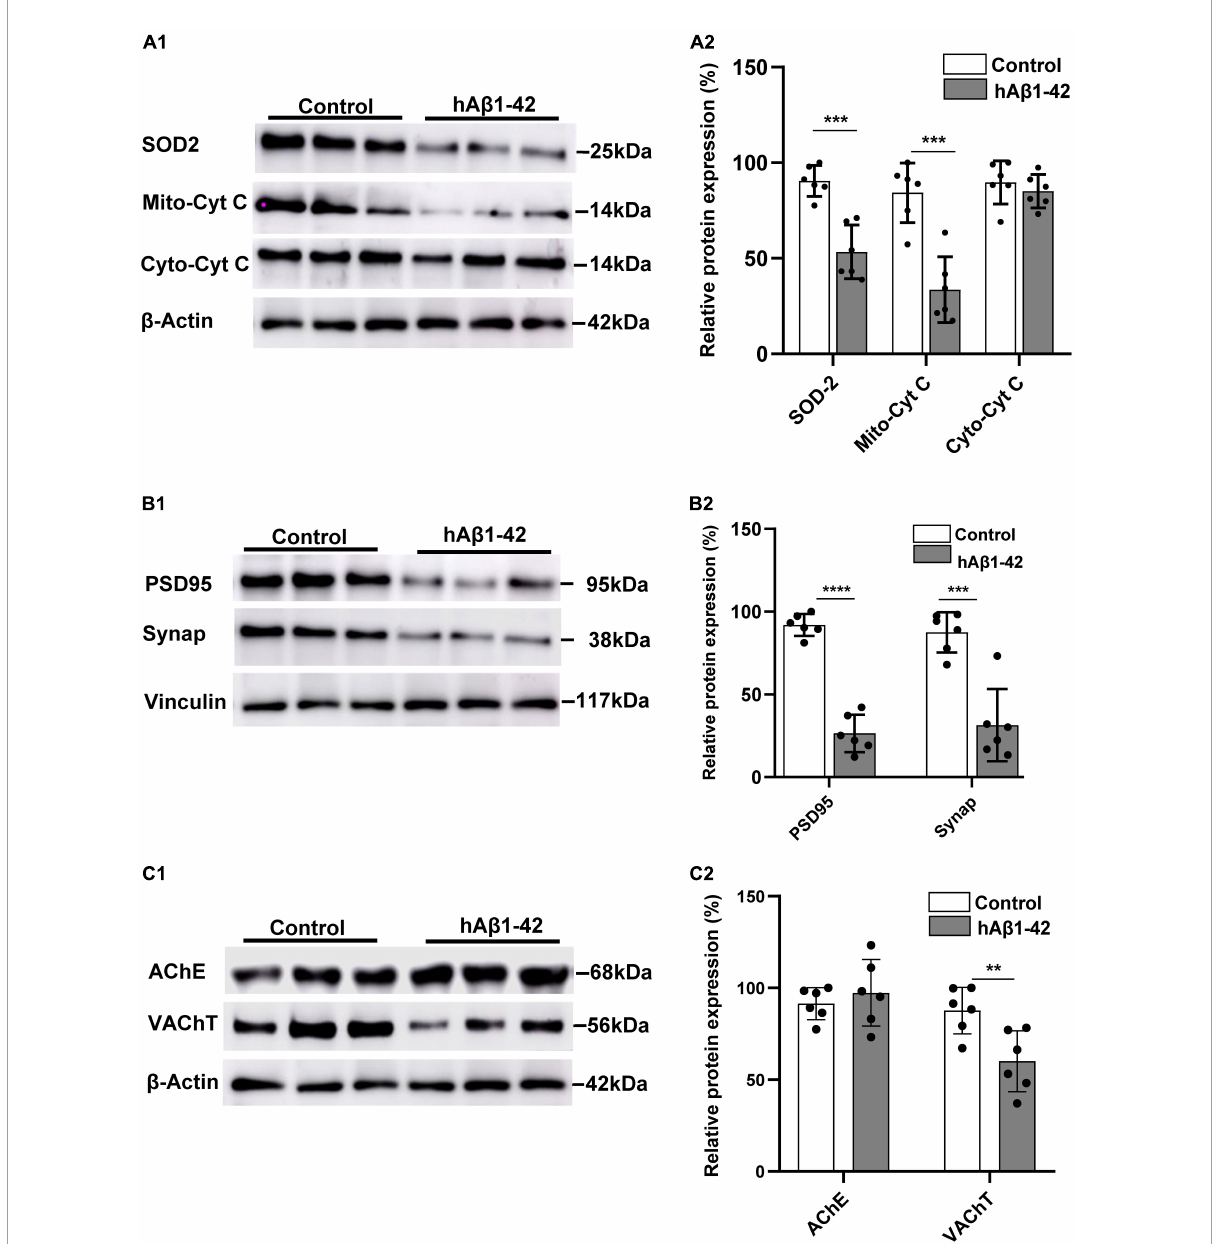
FIGURE2 Effects of hA β 1 − 42 on key mitochondrial elements, synaptic proteins, and cholinergic markers in the entorhinal cortex. (A1) Representative immunoblots of mitochondrial superoxide dismutase 2 (SOD2), mitochondrial cytochrome c (Mito-cyt C), cytosolic cytochrome c (Cyto-cyt C), and β -actin loading control in entorhinal lysates treated with hA β 1 − 42 and control medium. (A2) Normalized expression of SOD2, Mito-cyt C, and Cyto-cyt C in hA β 1 − 42 -treated entorhinal samples compared to control ( n = 6). (B1) Representative immunoblots of postsynaptic density protein (PSD95), presynaptic marker synaptophysin (Synap), and vinculin loading control in entorhinal lysates. (B2) Quantification data showing the normalized expression of both PSD95 and Synap in slices incubated with hA β 1 − 42 vs. control ( n = 6). (C1) Representative immunoblots of cholinergic markers acetylcholinesterase (AChE), vesicular acetylcholine transporter (VAChT), and β -actin (loading control). (C) Bar graphs showing normalized expression of AChE and VAChT in hA β 1 − 42 –treated slices and control ( n = 6) (** p < 0.01; *** p < 0.005; **** p < 0.0001).